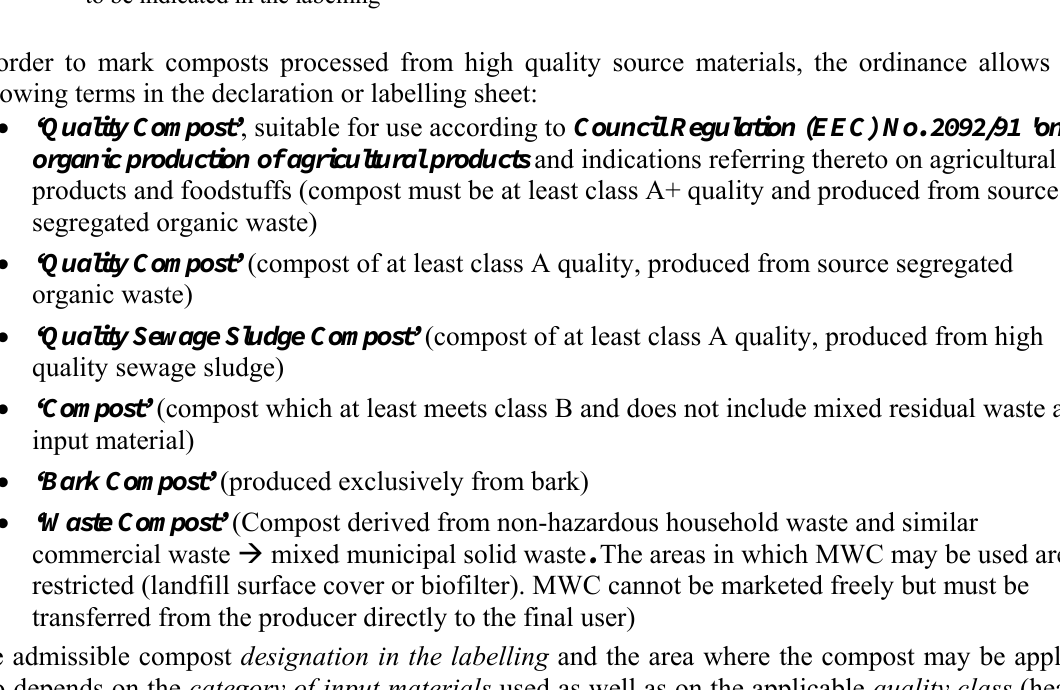
SEWAGE SLUDGE for ‘ quality sludge compost for